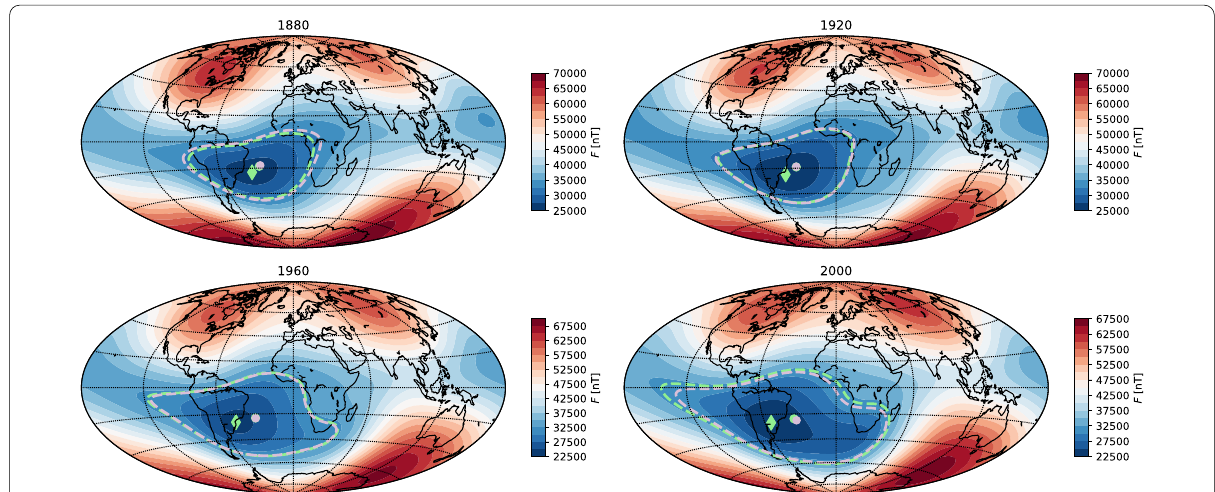
Fig. 3 Geomagnetic field intensity at Earth’s surface for the mean model of COV‑OBS.x1 at four snapshots (Gillet et al. 2015). Dashed green contours denote the S 0 area, dashed purple contours denote the S 1 area. Green diamonds denote the Min center, green and purple circles denote the centers of mass CM0 and CM1, respectively. Note the different scales from top to